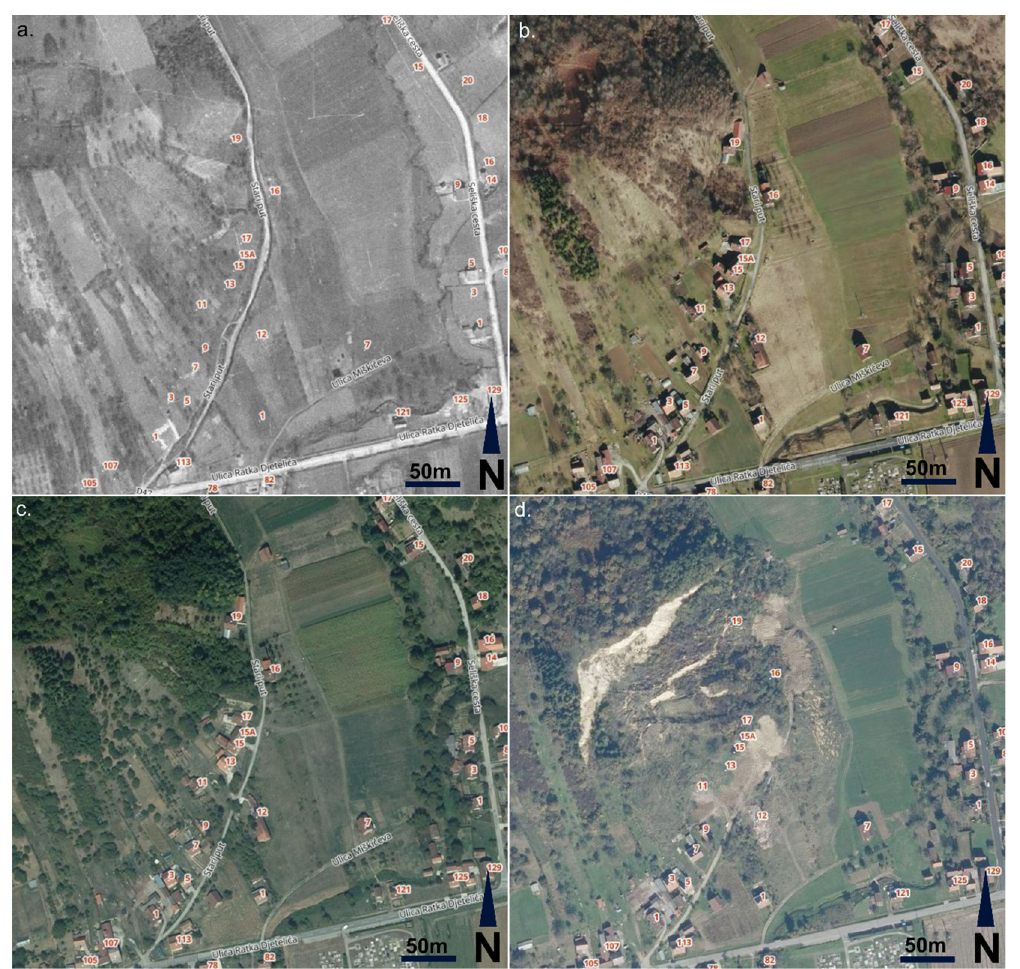
Figure 5. Hrvatska Kostajnica landslide area orthophotos from National Geodetic Administration of Croatia (NGA): ( a ) from 1968—historical data; ( b ) from 2016—pre-failure data; ( c ) from 2018—(recent) pre-failure data; and ( d ) from 2020—post-failure data.